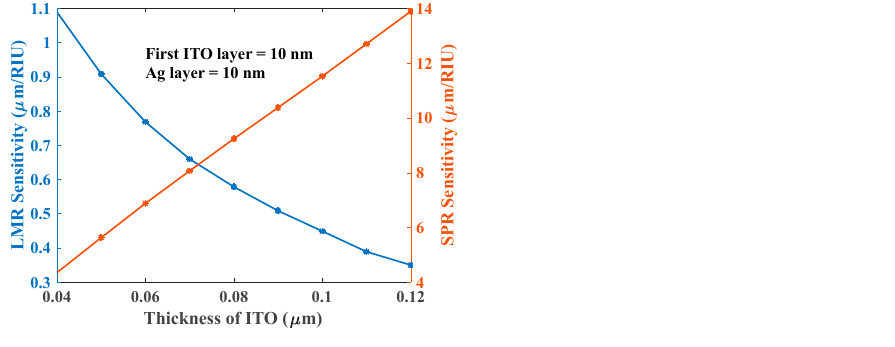
Figure 8. Normalized transmission spectra of sensing probe with ( a ) ITO (10 nm) + Ag (10 nm) +